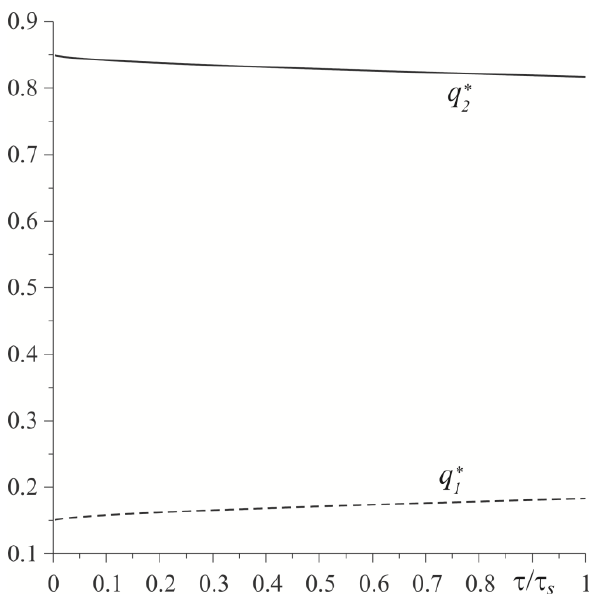
Figure 5. Evolutions of dimensionless intensities of heat fluxes q ∗ normal from the friction surface to the insides of the elements made of cast iron (solid line) and FGM (dashed line) under uniform sliding.